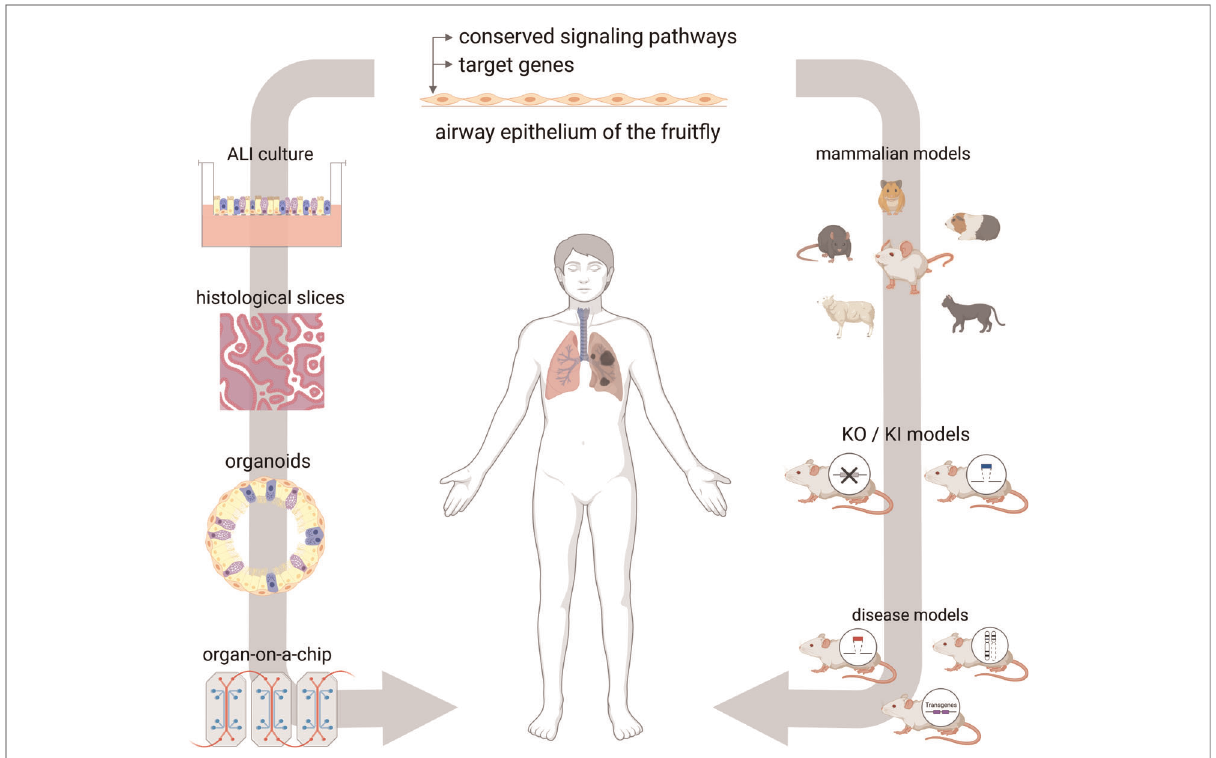
FIGURE 3 Future directions. The airway epithelium of D. melanogaster offers a great tool for the investment of conserved pathways and target genes. On that basis, fi ndings can be investigated in mammalian models, such as knock-down (KD) and knock-in (KI) models or disease models. On the other hand, fi ndings can be transferred to in vitro models using human cell culture systems, histological slices, organoids or organ-on-a-chip approaches. Figure was created with